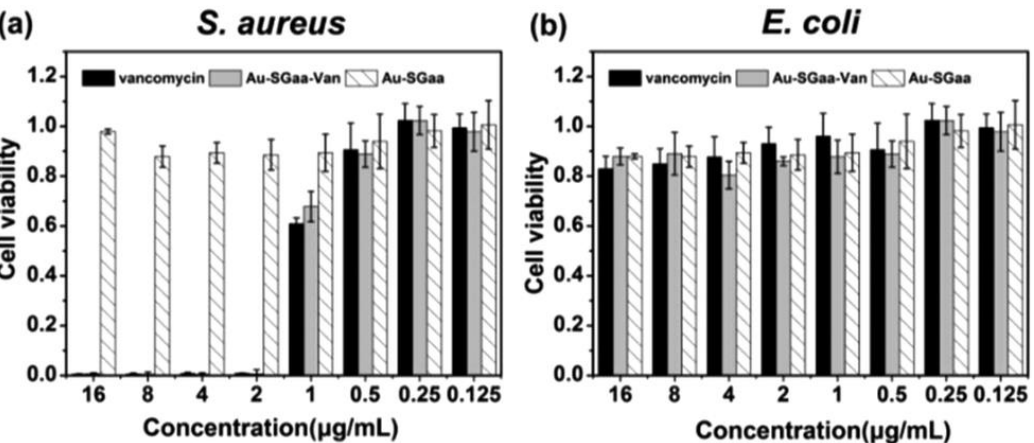
Figure 8. (a) Antibacterial activity of Au-SGaa-Van, vancomycin and Au-SGaa against Gram-positive S. aureus . (b) Antibacterial activity of Au-SGaa-Van, vancomycin and Au-SGaa against Gram-negative E. coli . Reproduced with permission from Reference [81]. Copyright © 2018, Royal Society of Chemistry.